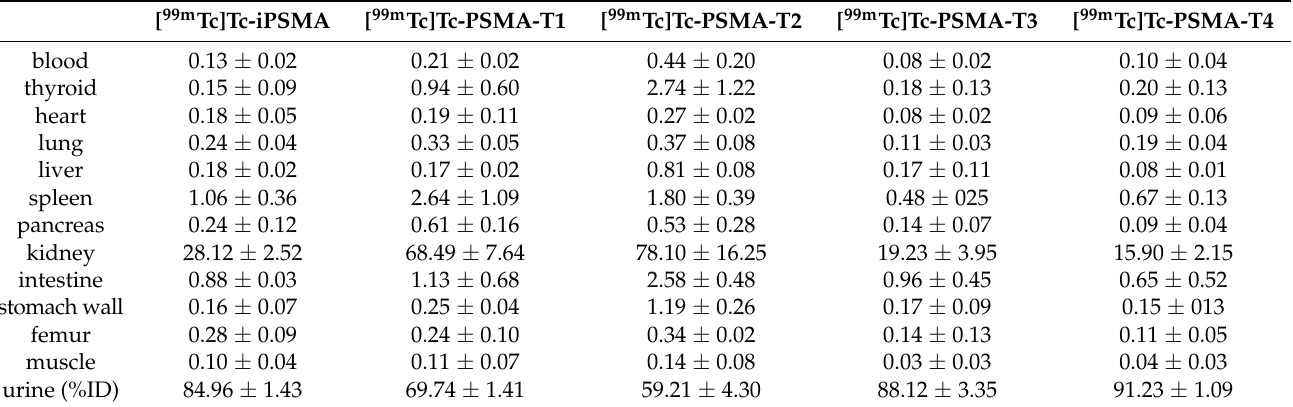
Table 6. Results of biodistribution study of 99m Tc-PSMA ligands in BALB/c mice ( n = 5) at 4 h after